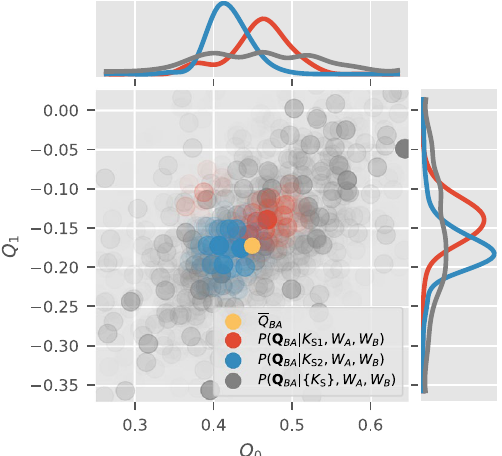
Figure 4. Clustering of the angular displacement distribution (ADD) for 1000 sentinel patterns given two independently reconstructed volumes W A and W B , in the space of possible unit quaternions. Only the first two components of these quaternions ( Q 0 , Q 1 ) are shown. The disks represent the set of most significant relative quaternions given each sentinel pattern, { Q BA | K S } , as defined by all possible pairs of those in Eq. (12). The opacities of these disks are proportional to the value of the ADD at these quaternions. The blue and red disks represent the ADDs for two specific sentinel patterns respectively. The yellow disk shows the average overall rotation Q BA as defined in Eq. (16).